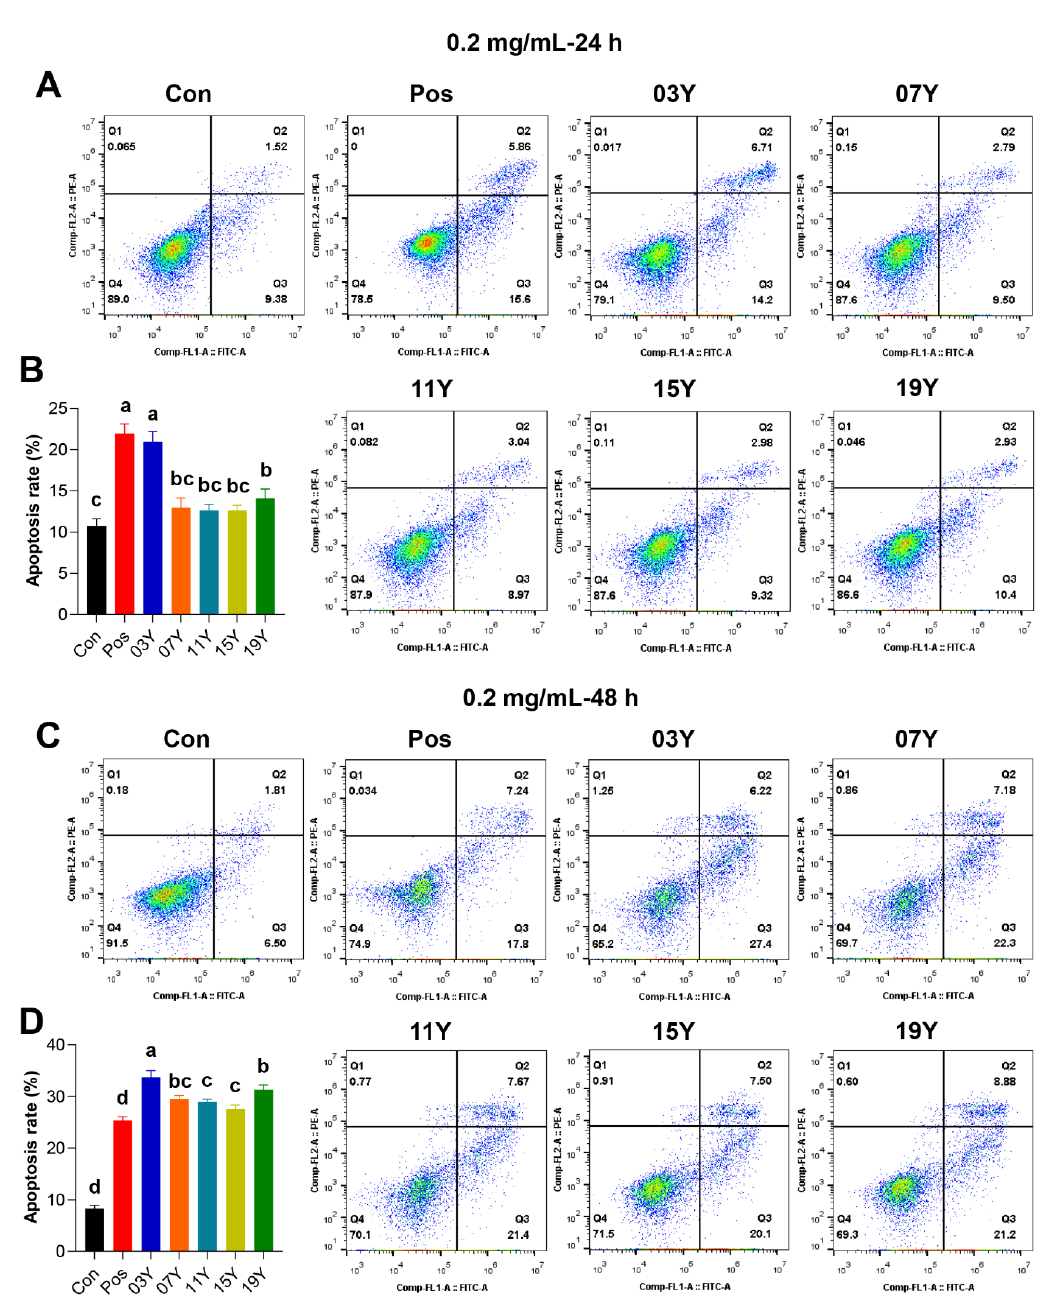
Figure 2. The promotion of apoptosis of HT-29 cells by tea extracts with various storage years. HT-29 cells were treated with 0.2 mg/mL extract of different tea samples 03Y , 07Y , 11Y , 15Y and 19Y for 24 ( A , B ) and 48 h ( C , D ), respectively. Total 0.2 mg/mL cisplatin was used as a positive control (Pos group). The proportion of apoptotic cells in each group was examined and counted using flow cytometry. One-way ANOVA analysis was performed between the treatments of multiple tea samples. The different lowercase letters (a, b, c, d) in the same group show the significant differences at p < 0.05 level.